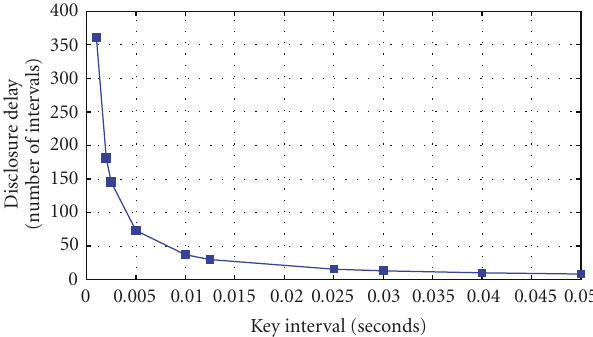
Figure 5: Key disclosure delay d as a function of key use interval Δ